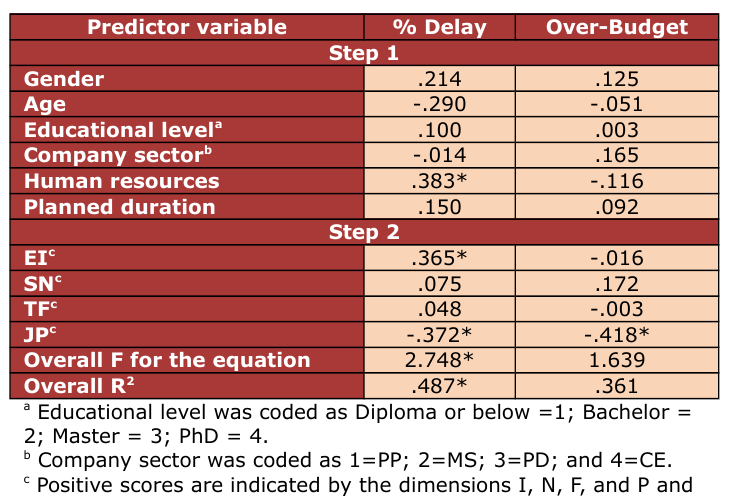
Table 10. Effect of EI, SN, TF and JP on traditional performance